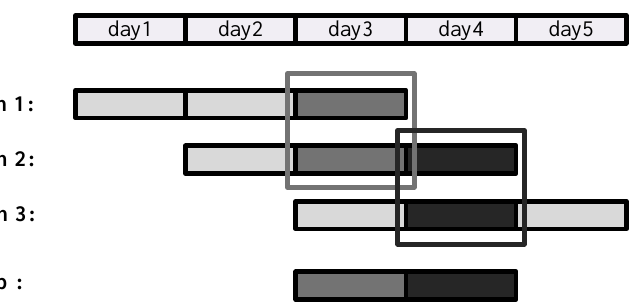
Figure 3. Three-day solution and orbit overlap